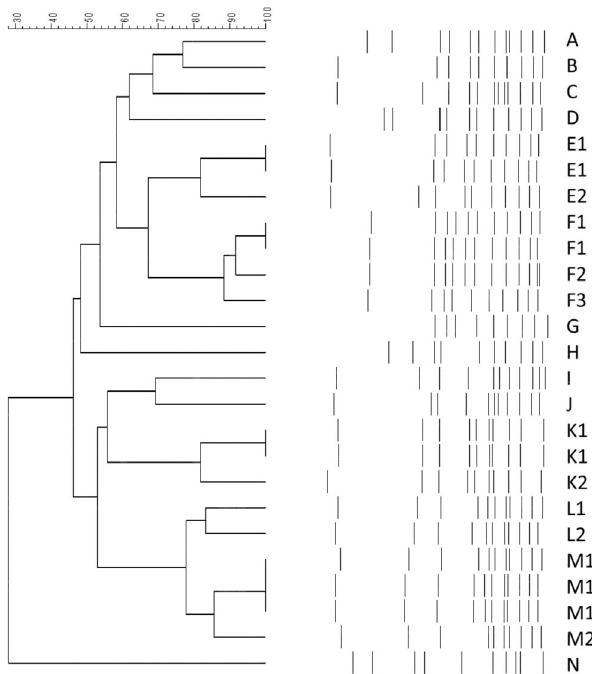
Figure 1. Pulsed-field gel electrophoresis (PFGE) dendrogram of XRDAB. The scale indicates the percentage of genetic similarity. 14 pulsotypes (A–N) and 20 pulsosubtypes (A–D, E1–E2, F1–F3, G–J, K1–K2, L1–L2, M1–M2, N) were